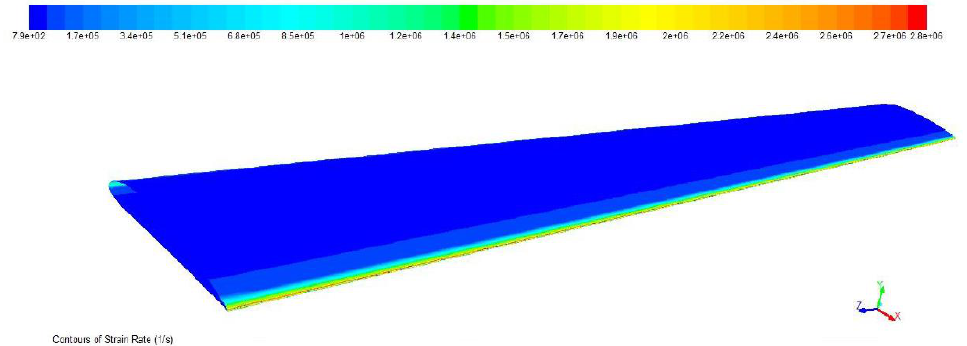
Figure 10: Strain rate on wind turbine blade surface of glass fibre-resin for 65 ms −1 wind velocity and sand injection from 6 0° angle